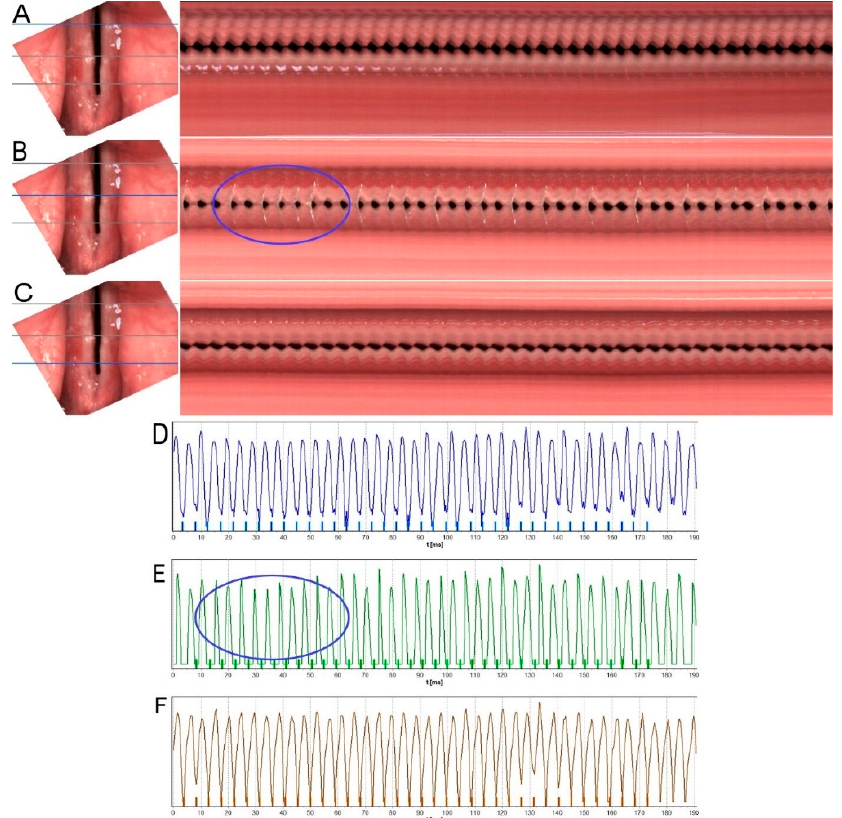
Figure 3. Images of the glottis for Subject 2 before treatment, obtained by HSV recording. ( A – C )—on the left: rotated images of vocal folds with grey lines marking three cross-sections used for generating videokymograms. On the right: long videokymograms obtained for cross-sections marked with a blue line. Respectively: ( A )—posterior, ( B )—middle, ( C )—anterior part of the glottis. Blue ellipse marks most visible irregularity of vocal folds vibration. ( D – F )—Glottal Width Waveform (GWW) plots obtained from corresponding videokymograms: the posterior, middle, and anterior sections of the glottis, respectively. Blue ellipse marks irregularity seen in the middle kymogram.